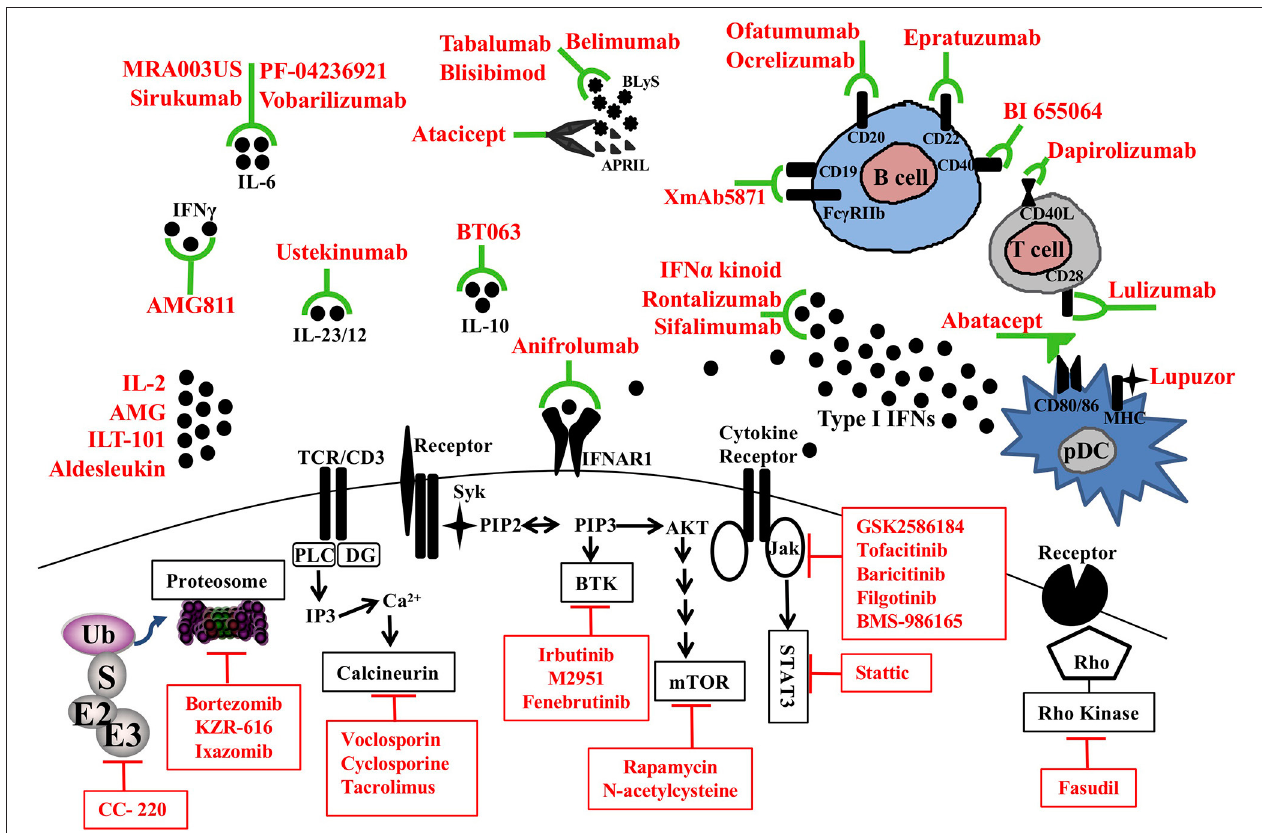
FIGURE 1 | Therapeutic targets and novel treatments in SLE. Target molecules (black) and corresponding therapeutic agents (red) in clinical trials are illustrated. pDC, plasmacytoid dendritic cell; MHC, major histocompatibility complex; CD, cluster of differentiation; APRIL, a proliferating-induced ligand; BLys, B-lymphocyte stimulator; IL, interleukin; TCR, T cell receptor; IFNAR1, Interferon alpha receptor 1; BTK, Bruton’s tyrosine kinase; mTOR, mammalian target of rapamycin; Jak, Janus kinases; STAT, signal transducer and activator of transcription proteins; Ub, ubiquitin; E3, Ubiquitin protein